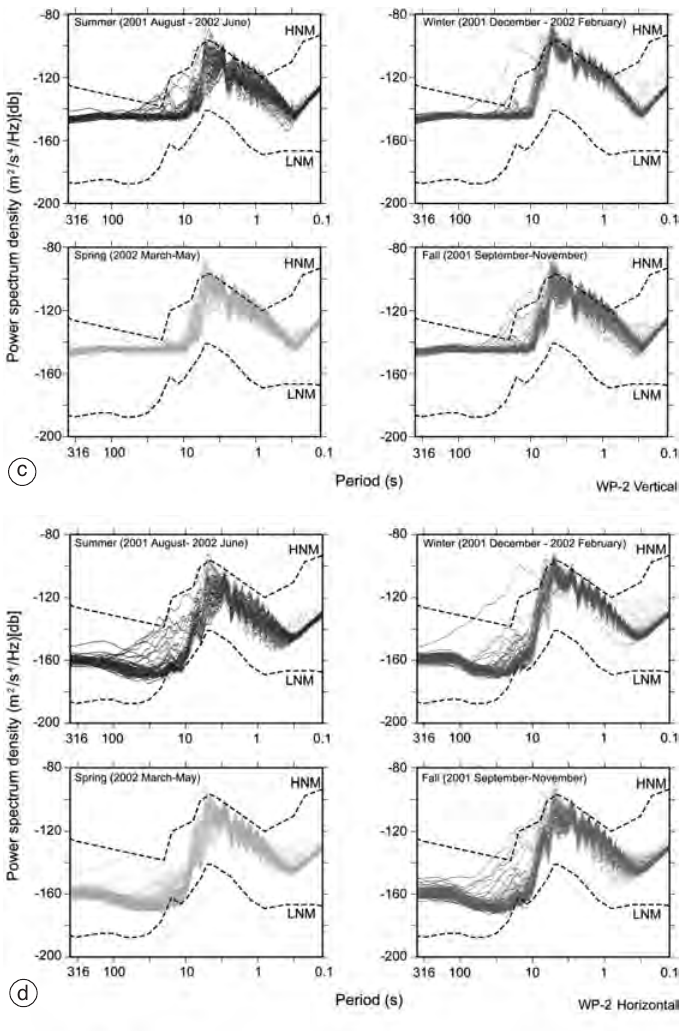
Fig. 8c,d. Power spectra of the deep-sea borehole seismic observatories. Power spectra estimated using one-hour records for the all observation period are plotted. HNM and LNM indicate the high noise model and the low noise model by Peterson (1993), respectively. The power spectra are grouped by seasons: c) for vertical component of WP- 2. The vertical component records of the WP-2 Observatory have also larger noise levels in periods longer than 10 s. d) For horizontal component of WP-2. The WP-2 Observatory has quiet noise environment in